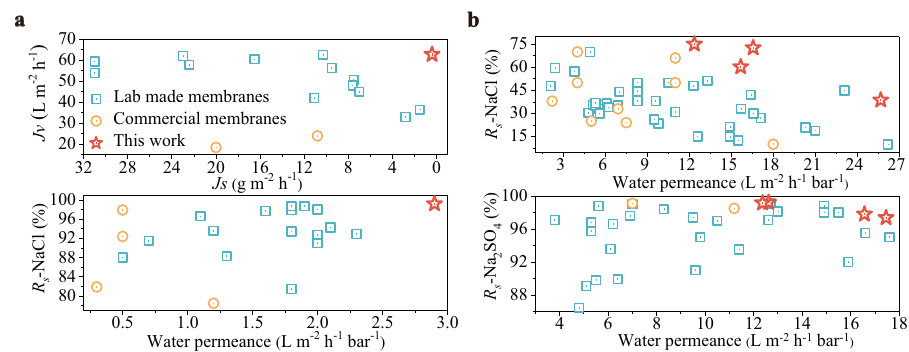
Fig. 6 Separation performance benchmarking. a Performance comparison with lab-made FO membranes (formed by MPD and TMC) and commercial FO membranes (upper) water fl ux versus reverse salt fl ux using 2 M NaCl solution and DI water as draw and feed solutions under PRO mode, and (bottom) intrinsic separation properties of water permeance and NaCl rejection. b Performance comparison with lab-made NF membranes (formed by PIP and TMC) and commercial FO membranes (upper) water permeance versus NaCl rejection, and (bottom) water permeance versus Na 2 SO